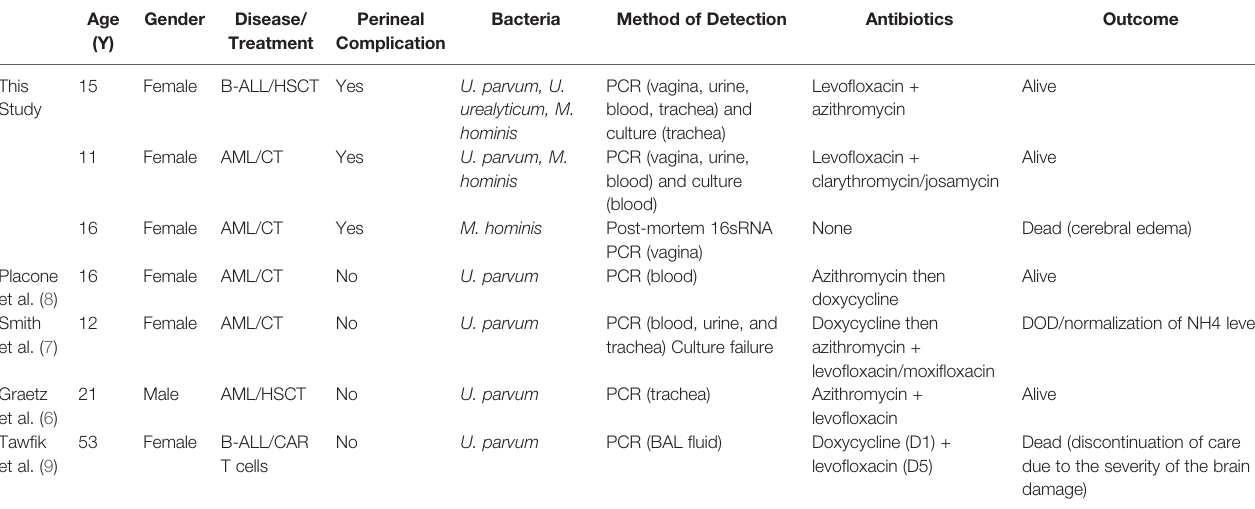
TABLE 3 | Comparison of cases of hyperammonemic encephalopathy due to Ureaplasma spp. and/or Mycoplasma hominis in immunocompromised patients treated for a malignant hemopathy found in the literature. Age Gender Disease/ Perineal Bacteria Method of (Y) Treatment Complication